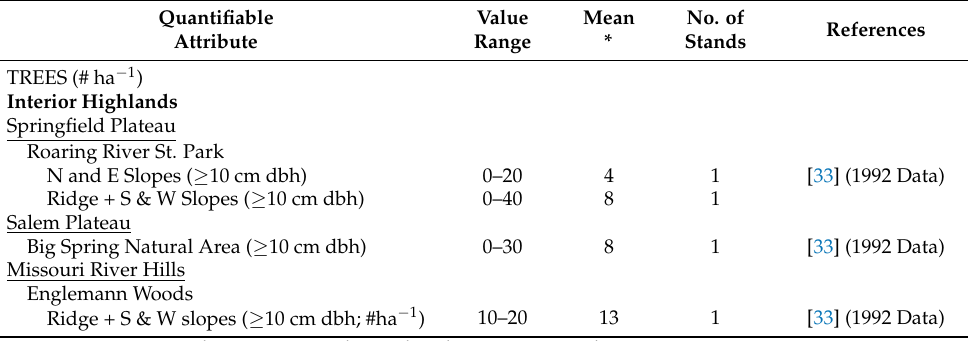
Table 8. Density (stems/ha) of dominant and co-dominant trees with at least one cavity >10 cm width. Quantifiable